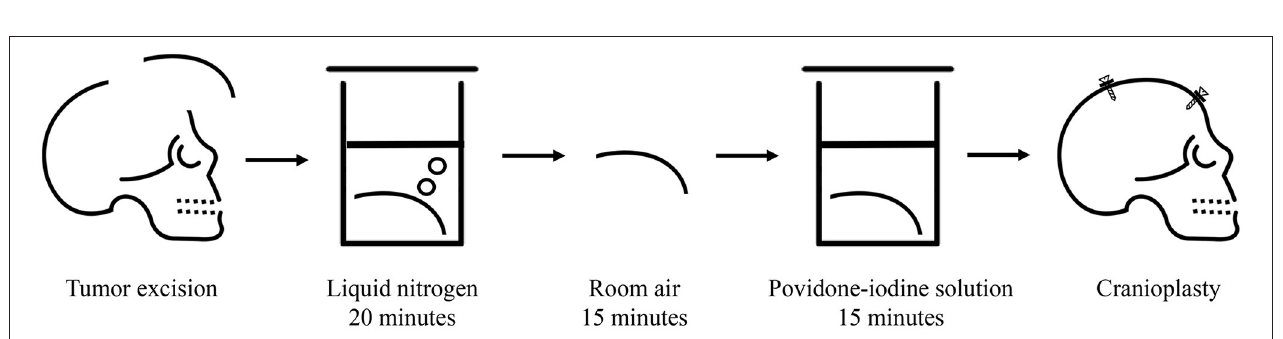
FIGURE 2 | Intraoperative images (A) Following reflecting the galea showing a well-demarcated extracranial tumor . (B) After removal of the extracranial tumor showing the osteoblastic tumor-bearing bone. (C) The intracranial tumor was removed with the preservation of the superior sagittal sinus (*). (D) Duraplasty with tensor fascia lata. (E) Ex vivo cryotherapy was done with the autologous bone graft by soaking it in liquid nitrogen for 20min (F) , thawing it in room air for 10min and soaking it in povidone-iodine solution for 15min. The nitrogen-treated graft (G) was fixed back in situ with plates and screws (H) .